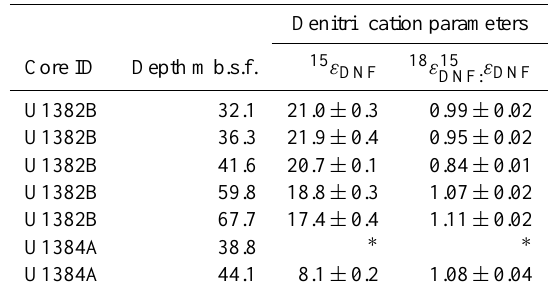
Table 2. Denitrification isotope effects 15 ε DNF and 18 ε : 15 ε DNF estimated from anoxic porewaters at North